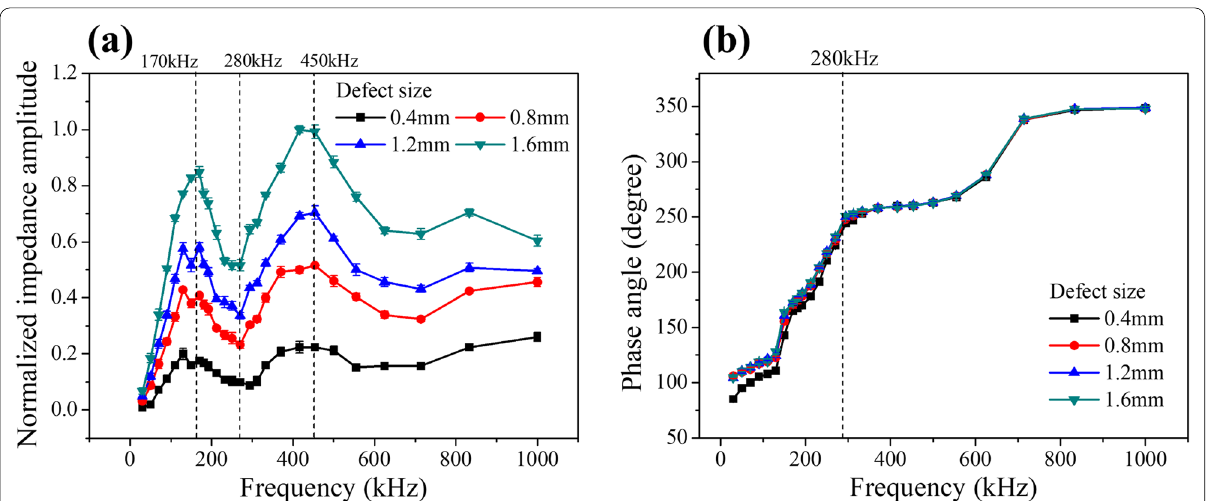
Figure 9 Relationship between excitation frequency and ( a ) normalized impedance amplitude and ( b ) impedance phase angle of the captured defect EC